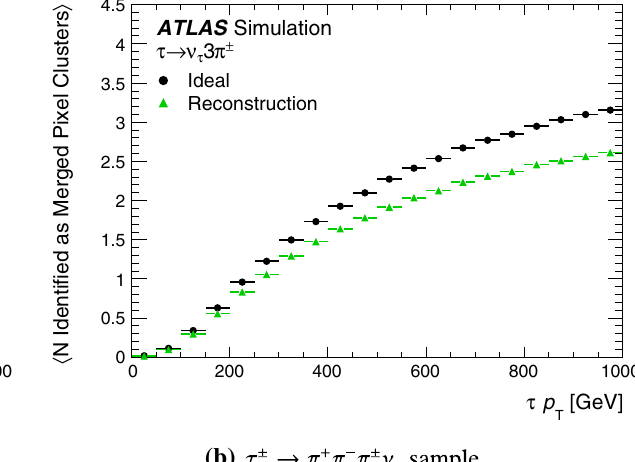
represents the true number of merged clusters, which would be obtained as the number of identified merged clusters in the case of perfect perfor- mance. It is required that the stable charged particles are created before the